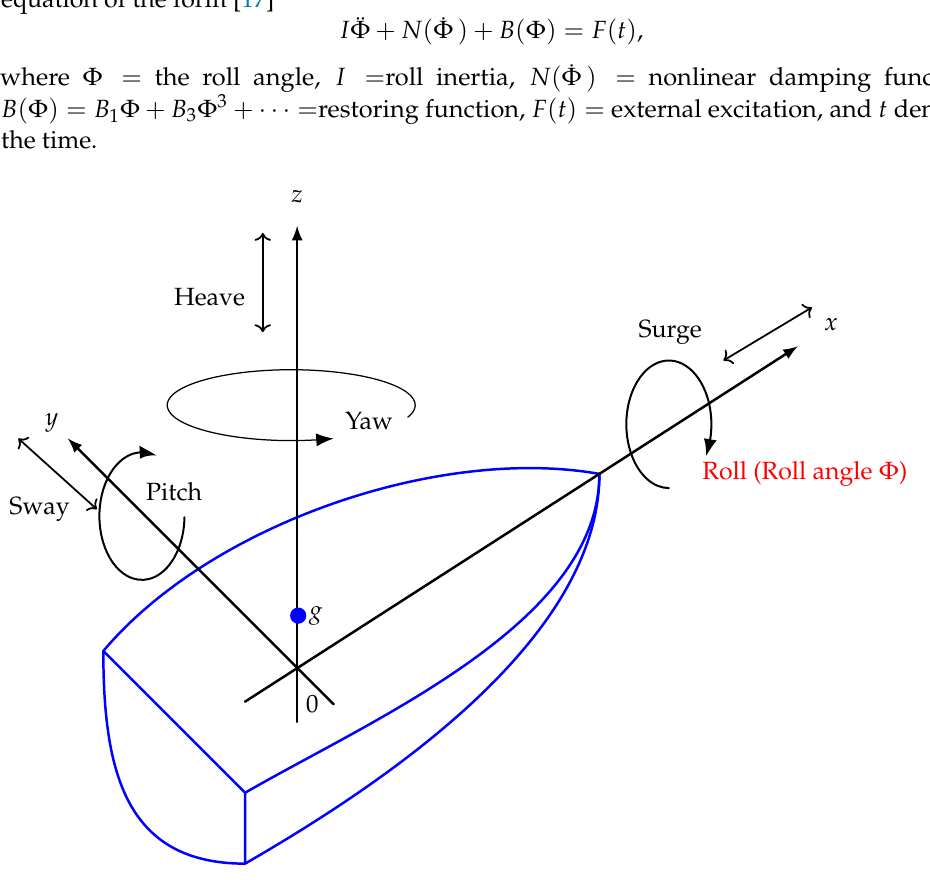
Figure 1. Schematic diagram of a ship with six degrees of